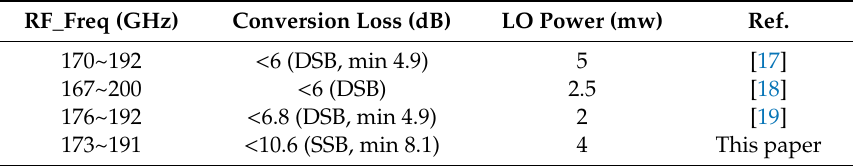
Table 3. Comparison of di ff erent sub-harmonic mixers working at 183 GHz.